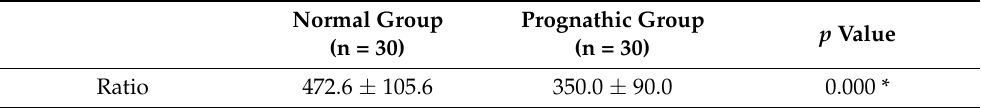
Table 1. Masseter muscle volume/length ratios of the normal and prognathic participants.